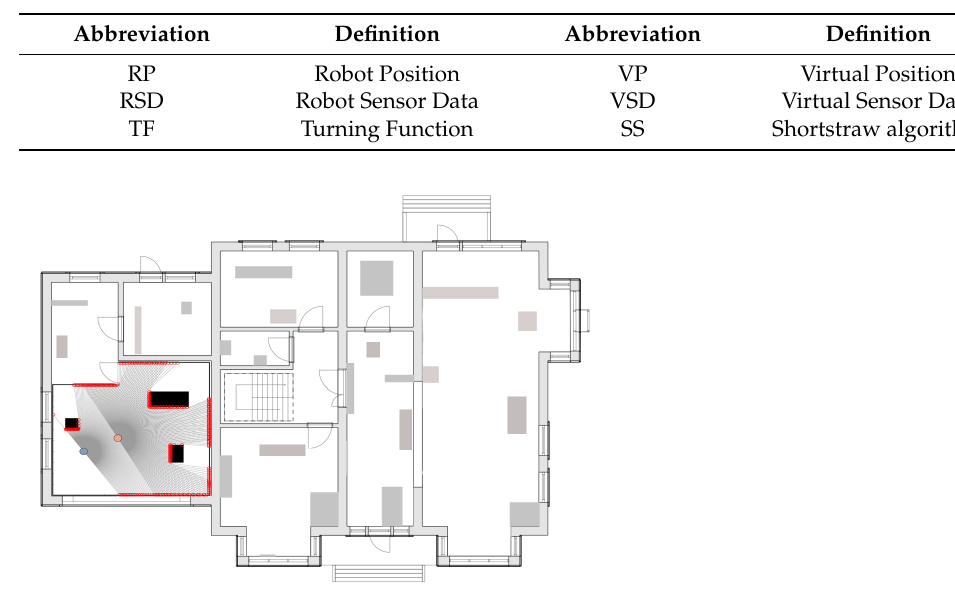
Figure 1. Schematic map of the office environment used for localization in this